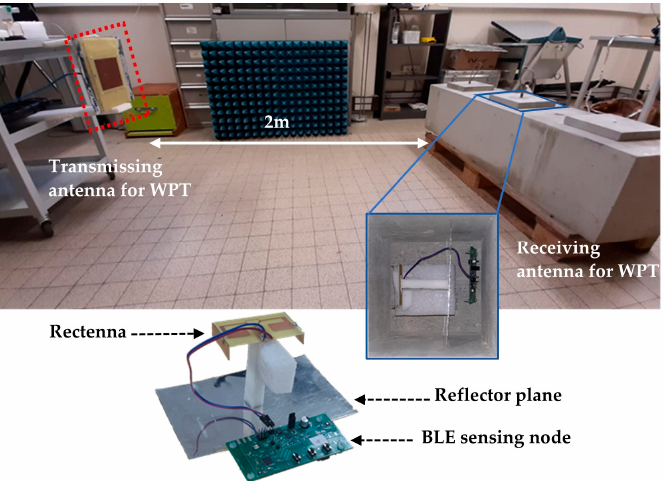
Figure 14. Photograph of the experimental setup for the sensing node embedded and powered by using WPT system in the concrete structure.